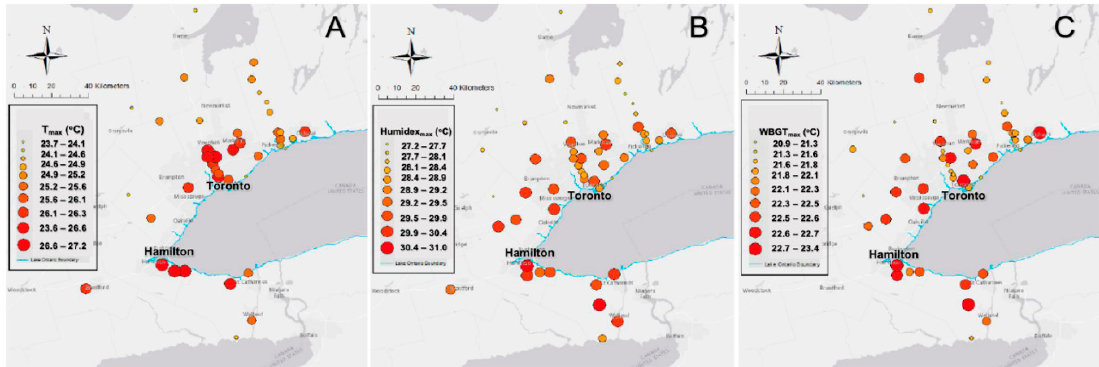
Figure 2. Station ‐ specific seasonal summer maximum ( A ) air temperature, ( B ) humidex, and ( C ) WBGT index averages. Each circle represents an individual station. The color and size of the circle reflect the magnitude of the heat metric, with darker and larger circles indicating higher values. Note that the scales differ between plots.